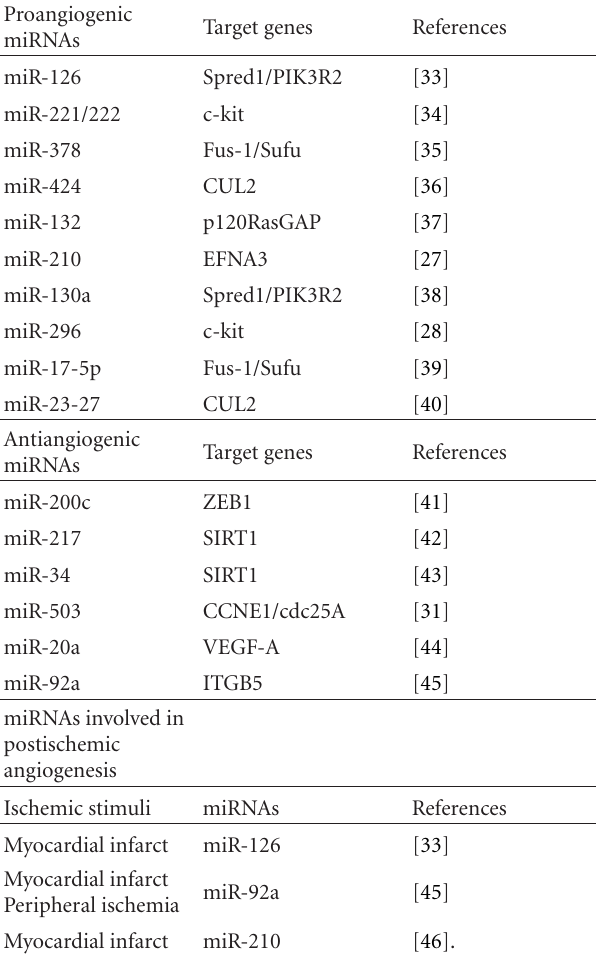
Table 1: microRNAs and target genes involved in neovascularisa-